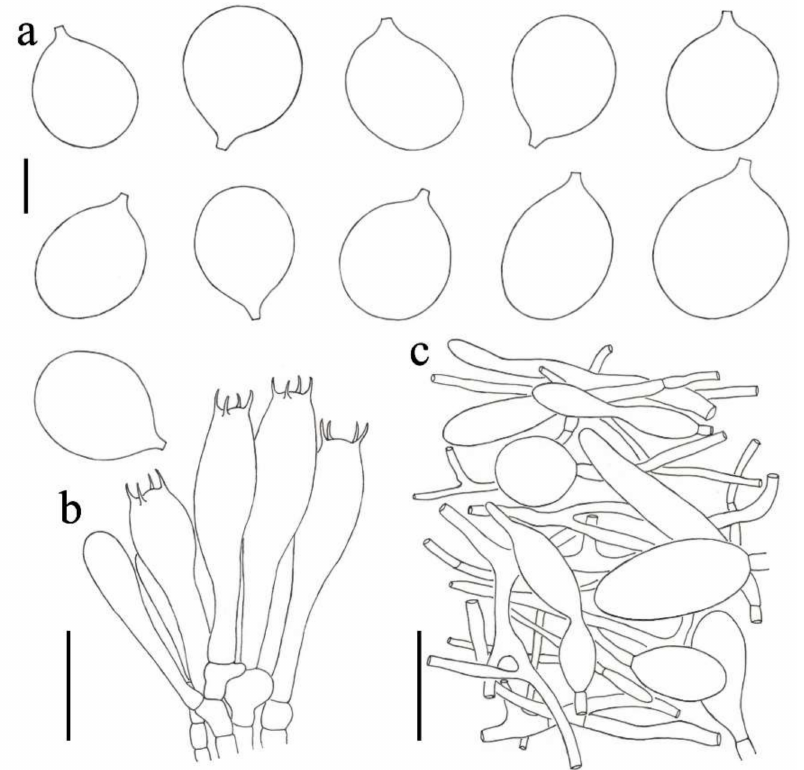
Figure 5. Amanita ravicrocina (CMUB-39967, holotype). ( a ) Basidiospores. ( b ) Hymenium and subhymenium. ( c ) Longitudinal section of volval remnants on pileus. Bars: ( a ) 4 µ m; ( b ) 20 µ m; ( c ) 40 µ